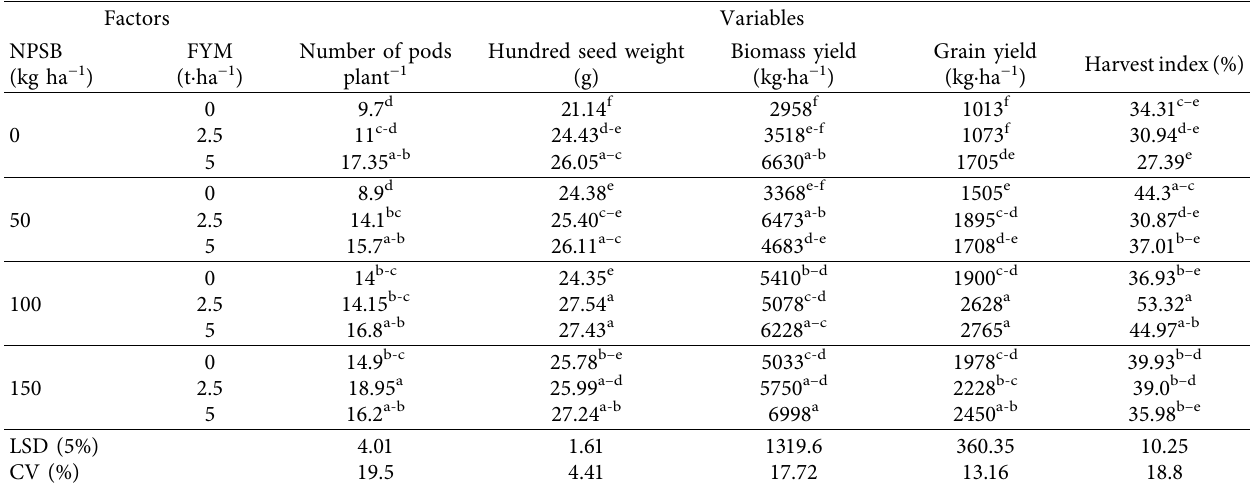
Table 8: Number of pods per plant, hundred seed weight, biomass yield, grain yield, and harvest index as afected by NPSB and FYM rates. Factors